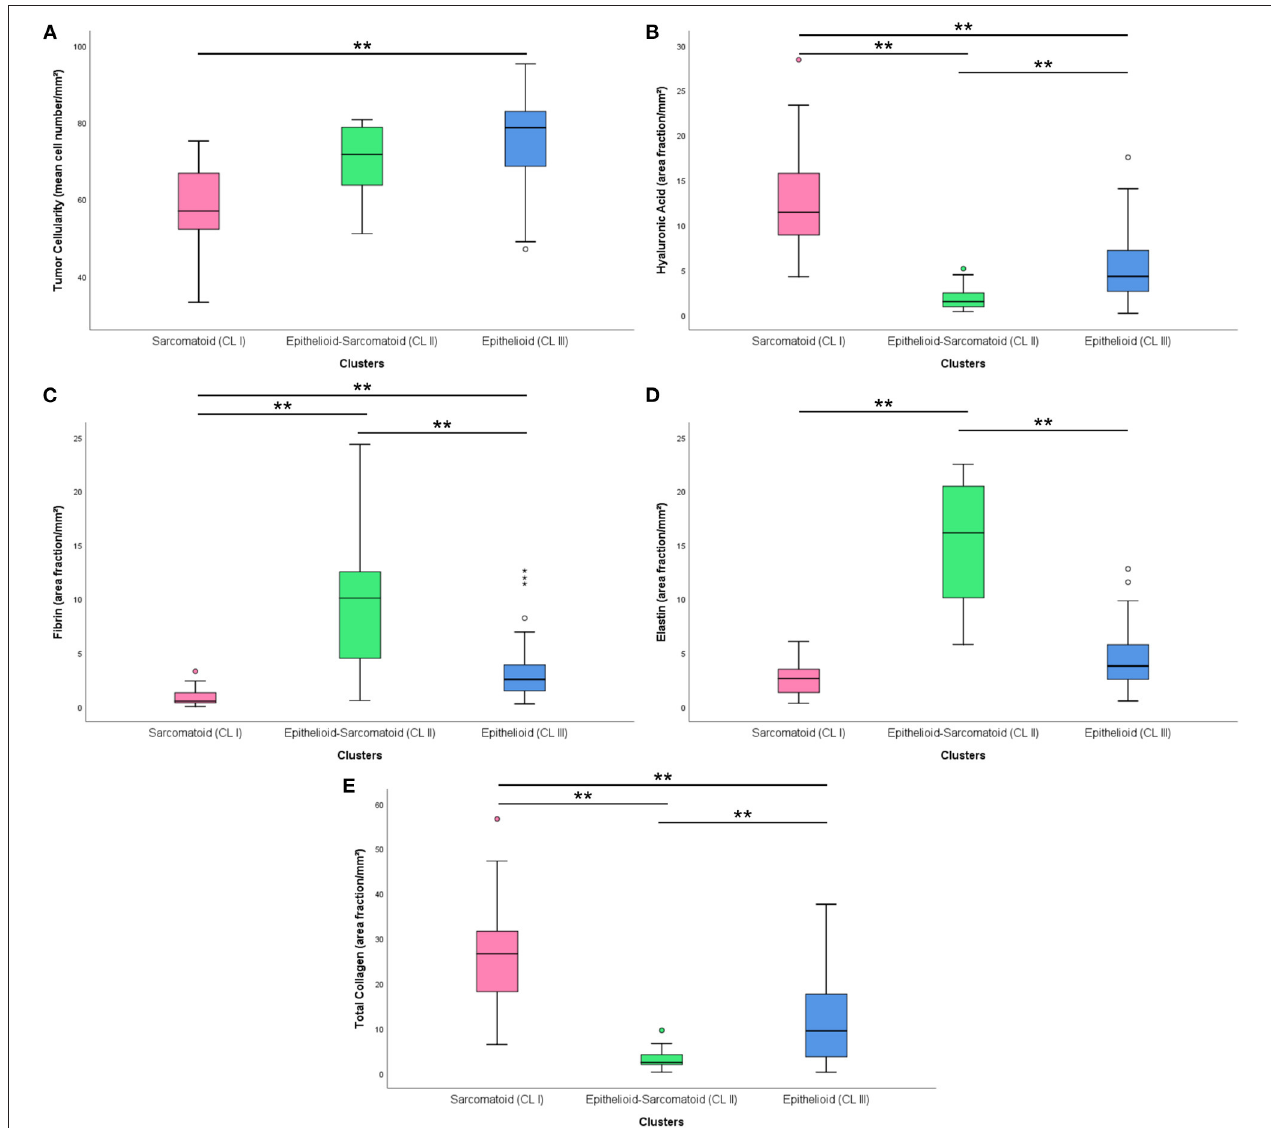
FIGURE 6 | Boxplots with the distribution of matrix elements [cellularity (A) , hyaluronic acid (B) , fibrin (C) , elastin (D) and total collagen (E) ] in different clusters. (**) was used when P ≥